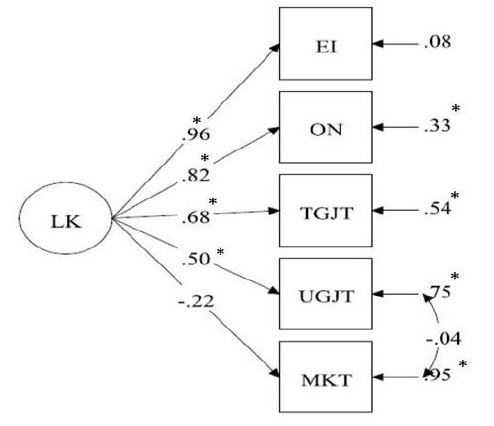
FIGURE 5 CFA Model 3 based on data from Bowles (2011)